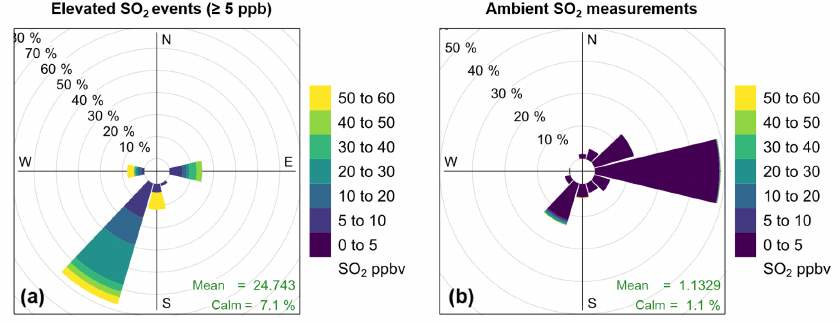
Figure 5. Pollution rose plots to show the relationship between wind direction and SO 2 concentration at the Bachok measurement site. Panel (a) represents recorded SO 2 concentrations ≥ 5ppb and panel (b) represents all SO 2 data recorded during the measurement period. Plot constructed using the openair package in RStudio (Carslaw and Ropkins, 2012; Carslaw,